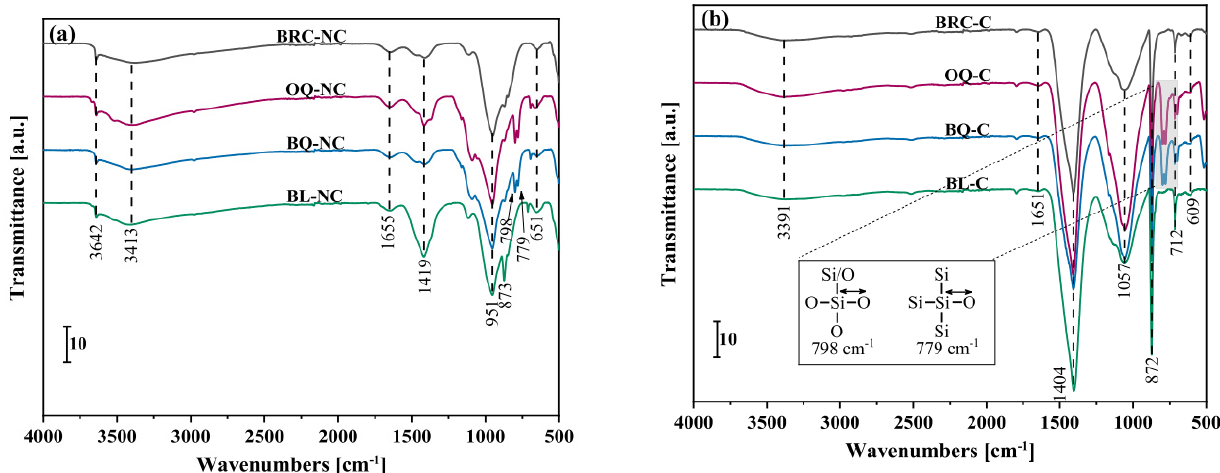
Figure 7. The variation of CH and CC content in non-carbonated (Ref, figure ( a )) and carbonated (0.55, figure ( b )) concretes. The dashed lines show the carbonation depth measured by indicator [26]. Note: BRC: Belite-rich cement paste; OQ: ordinary Portland cement and quartz paste, BQ: Belite-rich cement and quartz; BL: Belite-rich cement and limestone.